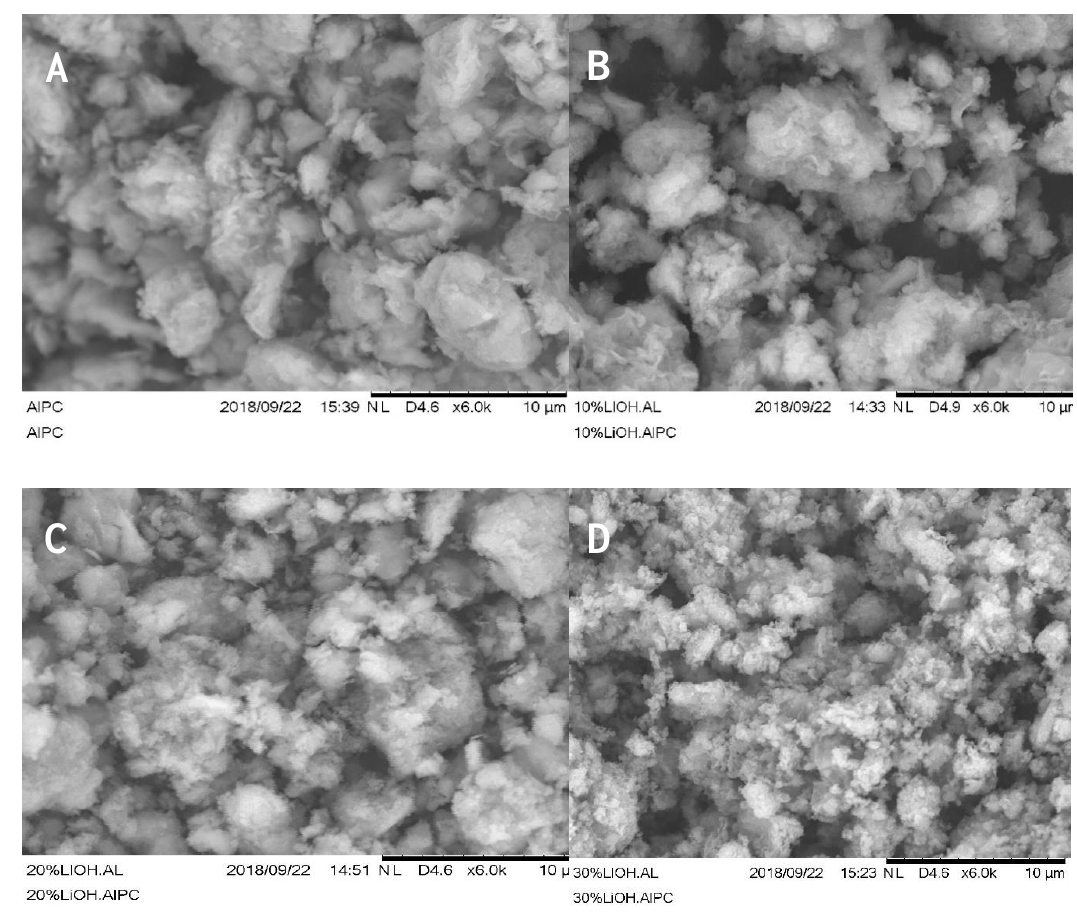
Figure 4. SEM images of ( A ) AlPC, ( B ) 10 wt. % Li / AlPC ( C ), 20 wt. % Li / AlPC and ( D ) 30 wt. % Li / AlPC catalysts.